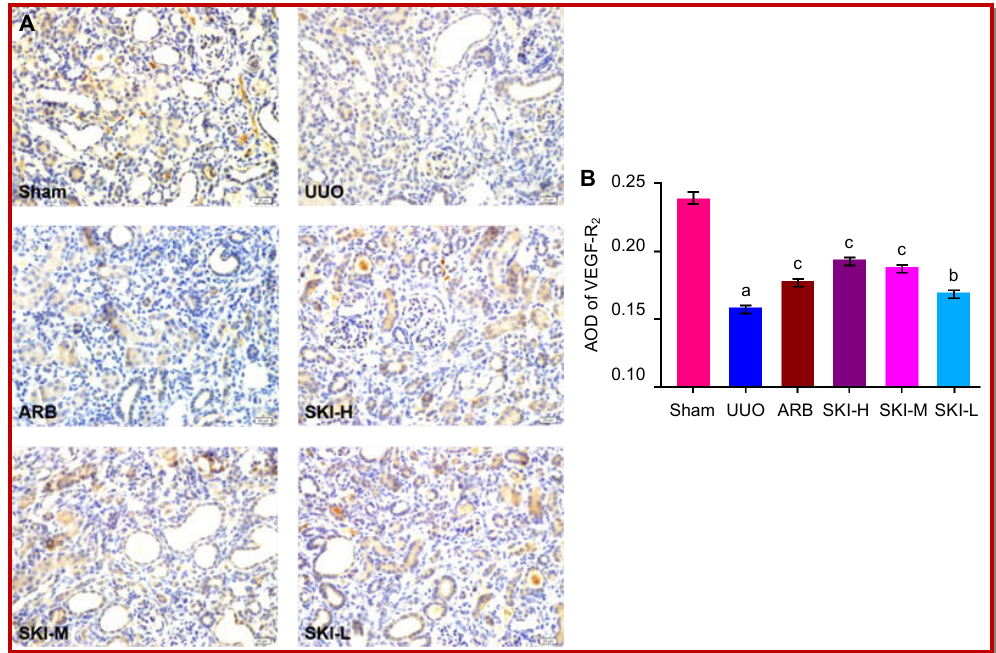
Figure 6: Effects of shenkang injection on expression of VEGFR 2 . (A) Expression of VEGFR2 were determined by immunohistochemistry, 400×; (B) Average optical density (AOD) of positive areas was calculated. Values are pre- sented as mean ± SD. a p<0.01 vs sham group, b p<0.05 vs UUO group, c p<0.01 vs UUO group; ARB means losartan; SKI-H means shenkang injection (7.8 g/kg); SKI-M means shenkang injection (3.9 g/kg); SKI-L means shenkang injection (1.95